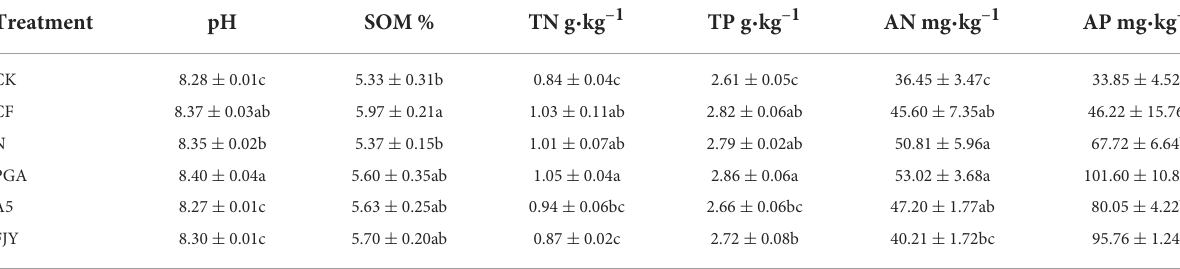
TABLE 2 Effects of different treatments on rhizosphere soil physicochemical properties.